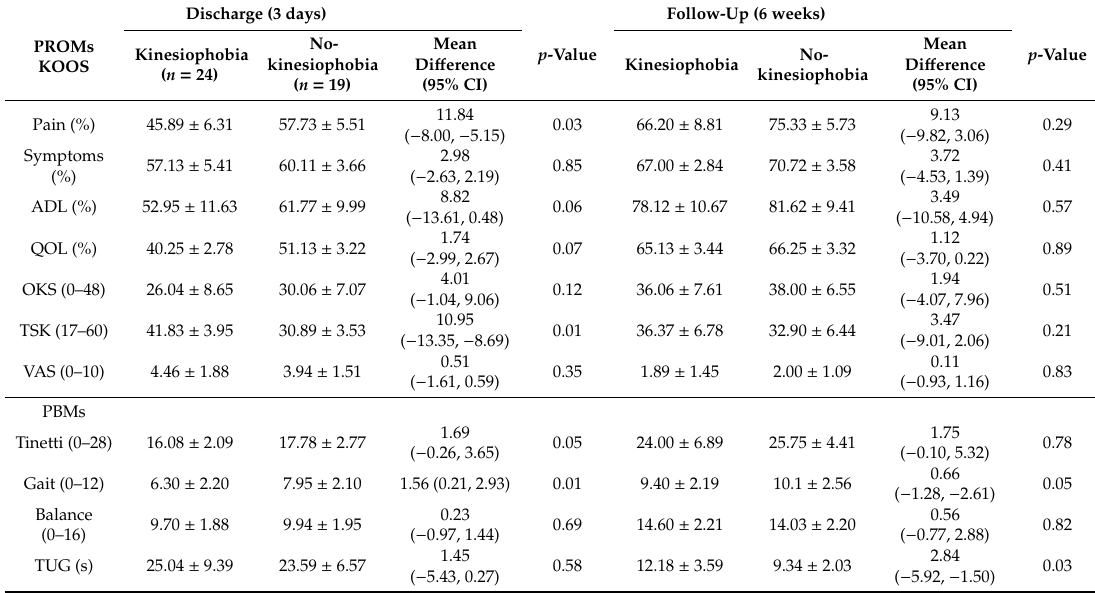
Table 2. Patient-reported and performance-based outcome at 3 days and 6 weeks post knee replacement surgery.